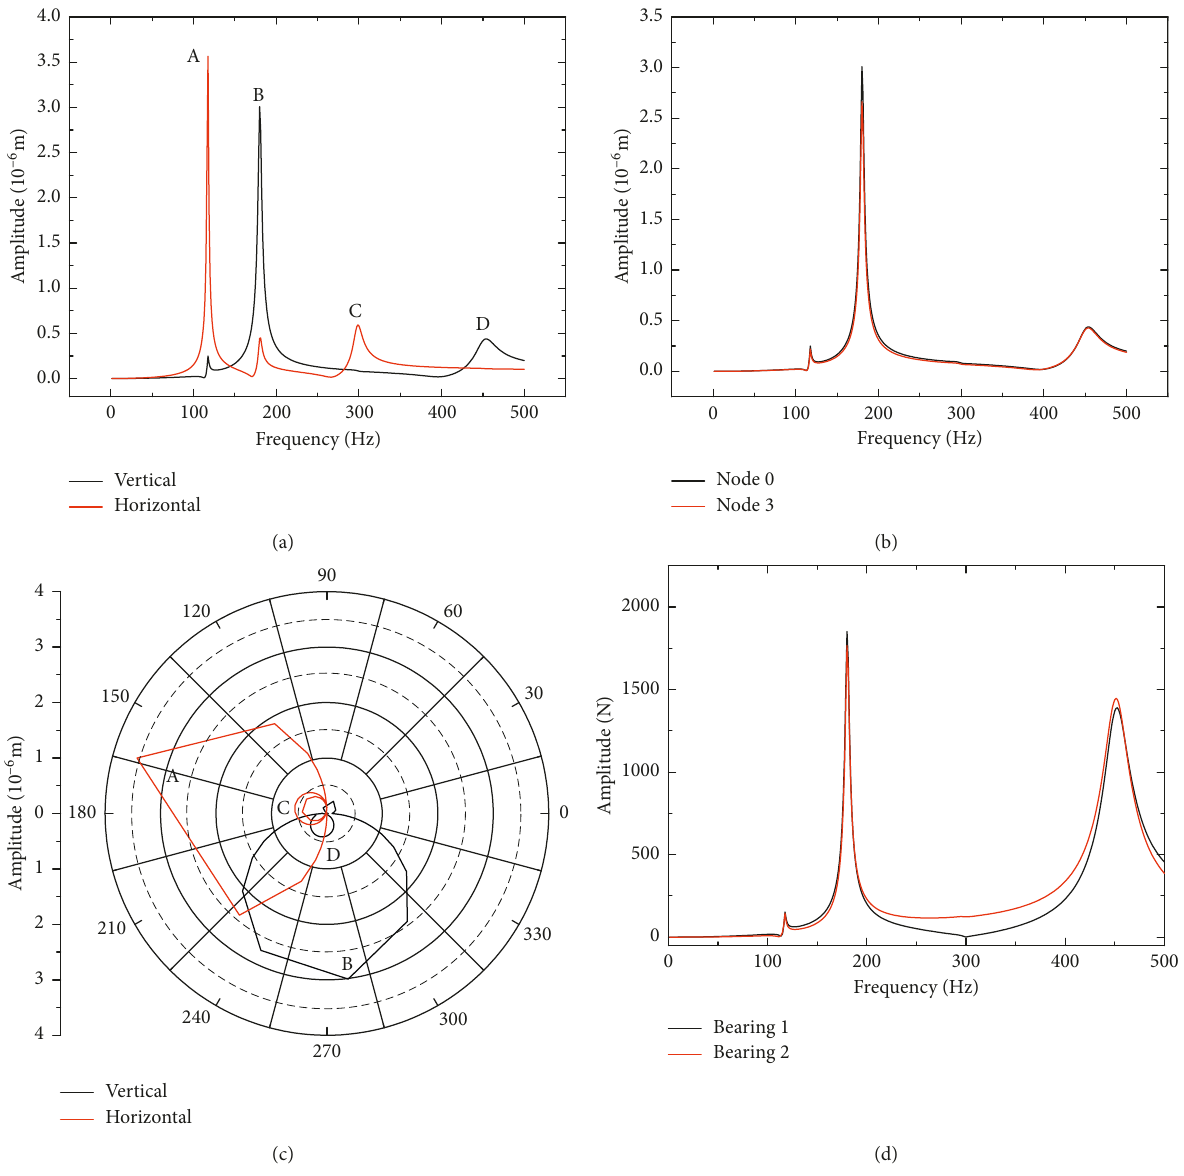
Figure 13: Rotor response and support reaction characteristics for condition 3 (anisotropic bearing stiffness). (a) Amplitude response at node 0. (b) Phase response for vertical direction at nodes 0 and 3. (c) Polar diagram for vertical direction at node 0. (d) Support reaction for bearings 1 and 2 at the vertical